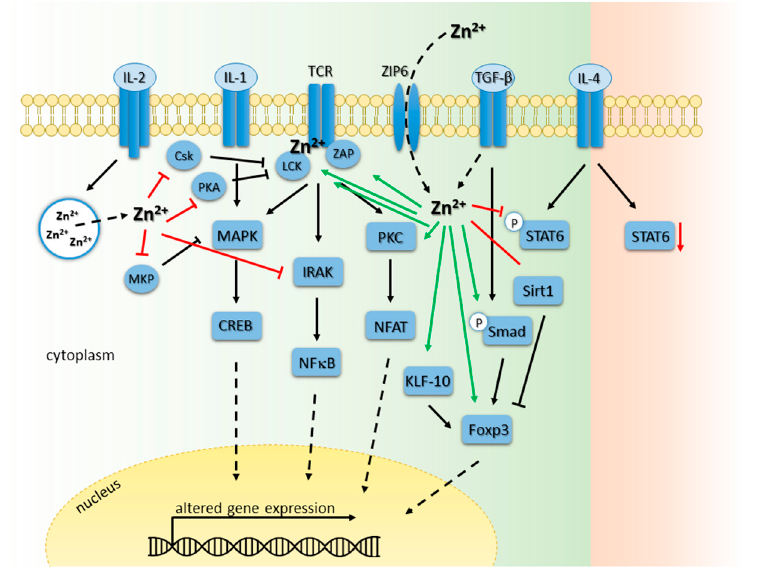
Figure 3. Influence of zinc signals on T cell signaling pathways. This figure presents an overview of T cell receptor (TCR)-, Interleukin-1 receptor (IL-1R)-, IL-2R-, IL-4R-, Transforming growth factor β 1 receptor (TGF- β 1R)-signaling in T cells, as well as zinc flux via zinc transporter ZIP6. Signaling pathways are described in detail in the text. Black arrow: activation, green arrow: activating function of zinc, red T bar: inhibiting function of zinc, black dotted arrow, translocation of the molecule to nucleus. Abbreviations: CREB: cyclic adenosine monophosphate response element-binding protein; Csk: c-src tyrosine kinase; Foxp3: forkhead-box-protein P3; IL: Interleukin; IRAK: interleukin-1 receptor-associated kinase; KLF-10: krüppel-like factor-10; Lck: lymphocyte-specific protein tyrosine kinase; MAPK: mitogen-activated protein kinase; MKP: MAP-kinase phosphatase; NFAT: nuclear factor of activated T cells; NF κ B: nuclear factor kappa B; PKA: protein kinase A; PKC: protein kinase C; SIRT1: Sirtuin1; STAT: signal transducer and activator of transcription; TCR: T cell receptor; TGF- β 1: transforming growth factor β 1. ZAP: zeta-chain (TCR)-associated protein kinase.